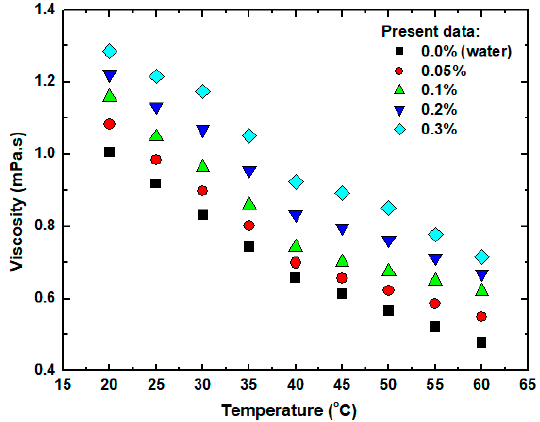
Figure 6. Variations of hybrid nanofluids viscosity versus temperature. The hybrid nanoparticles specific heat and density were calculated by Equations (4) and (5) and substituted in Equations (7) and (8) to get the hybrid nanofluids specific heat and density. where, C p , hnf is the hybrid nanofluids specific heat (J kg − 1 K − 1 ), C p , water is water